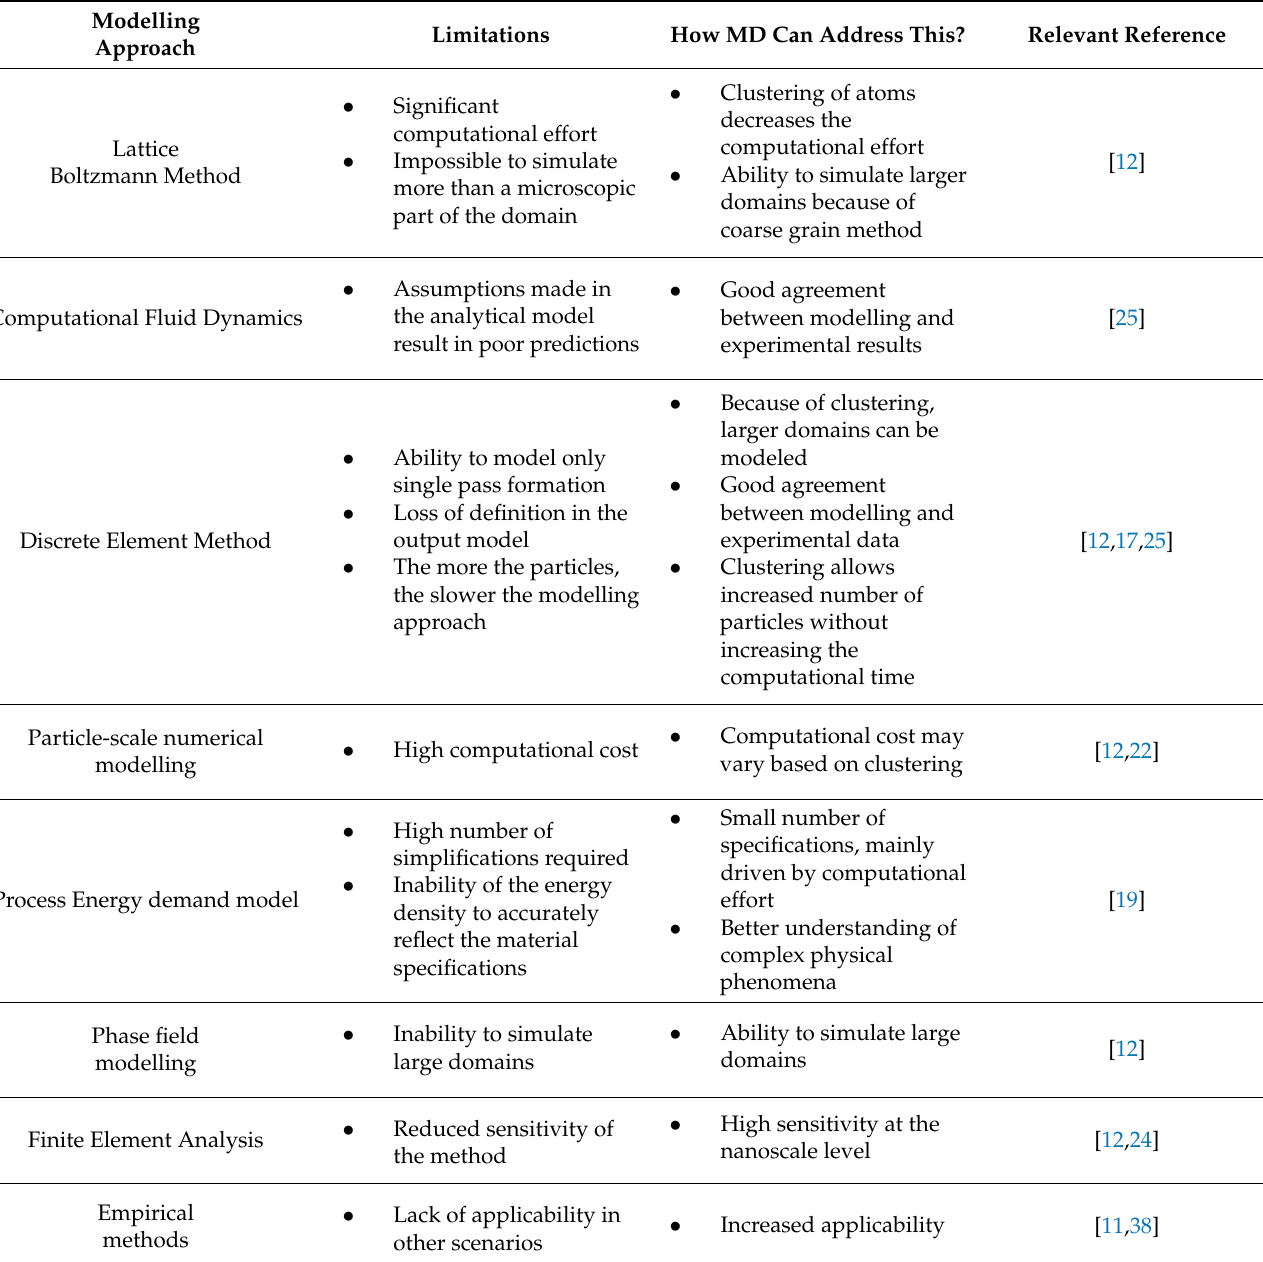
Table 2. Identifying limitations in the most frequently used modelling approaches and how MD can address